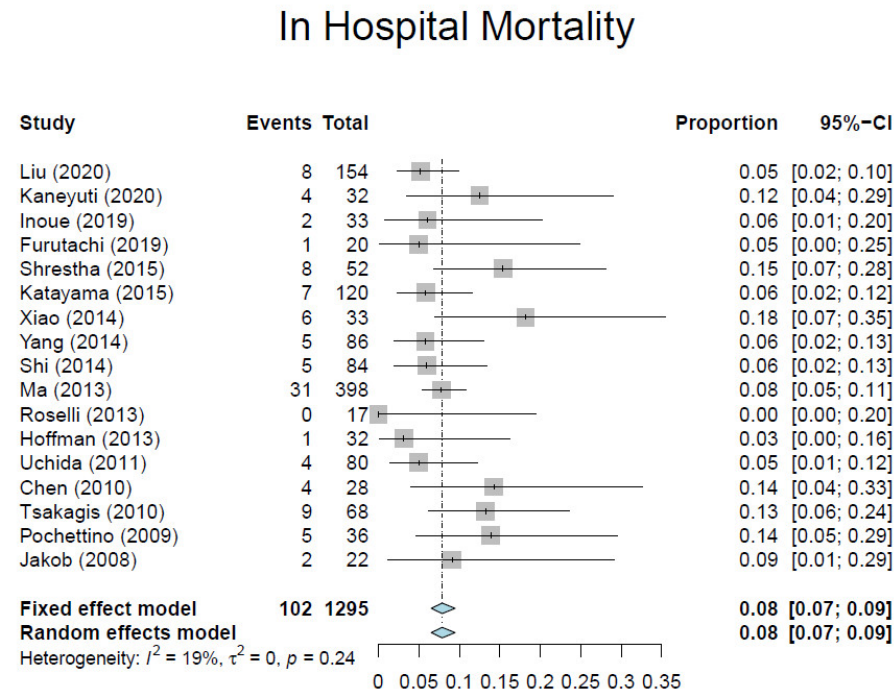
Figure 3. Forest plot depicting pooled estimates of hospital mortality.